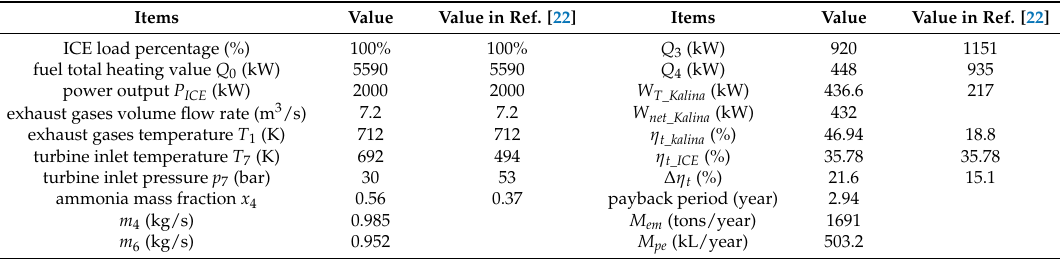
Table 6. Primary thermodynamic performance indices of bottoming